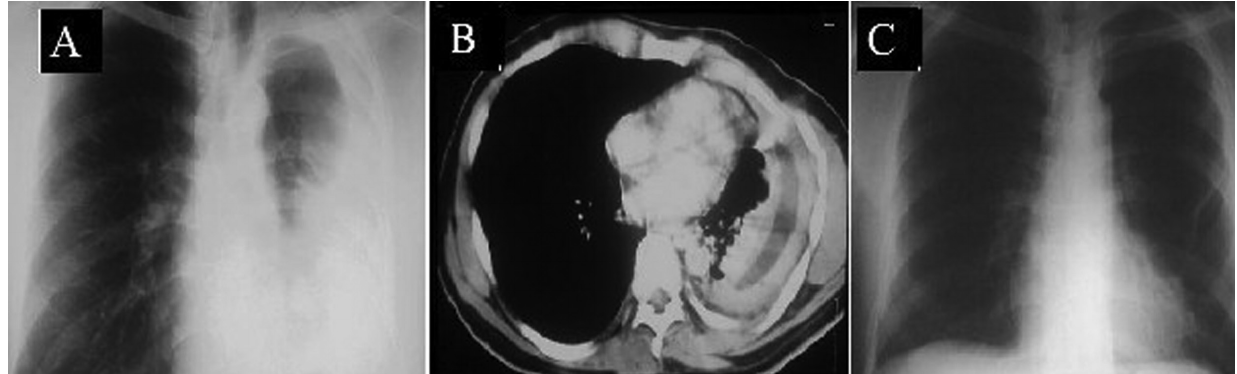
Figure 2 - A. Chest roentgenogram shows a large left empyema. B. Computed tomography of the chest showing significant restriction of the thoracic cage and thick pleural cortex. C. Postoperative chest roentgenogram with excellent pulmonary expansion (Incidentally, partial removal of a rib can be seen; this was the only patient that required such a